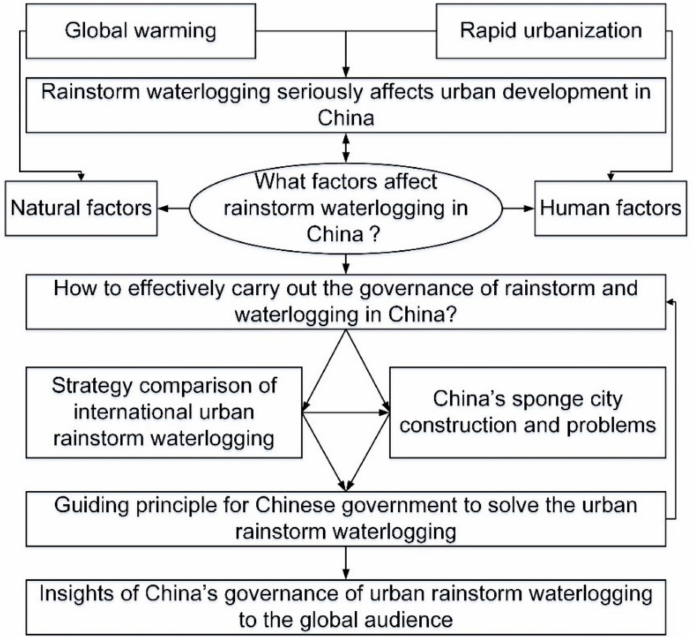
Figure 1. The logical framework of this